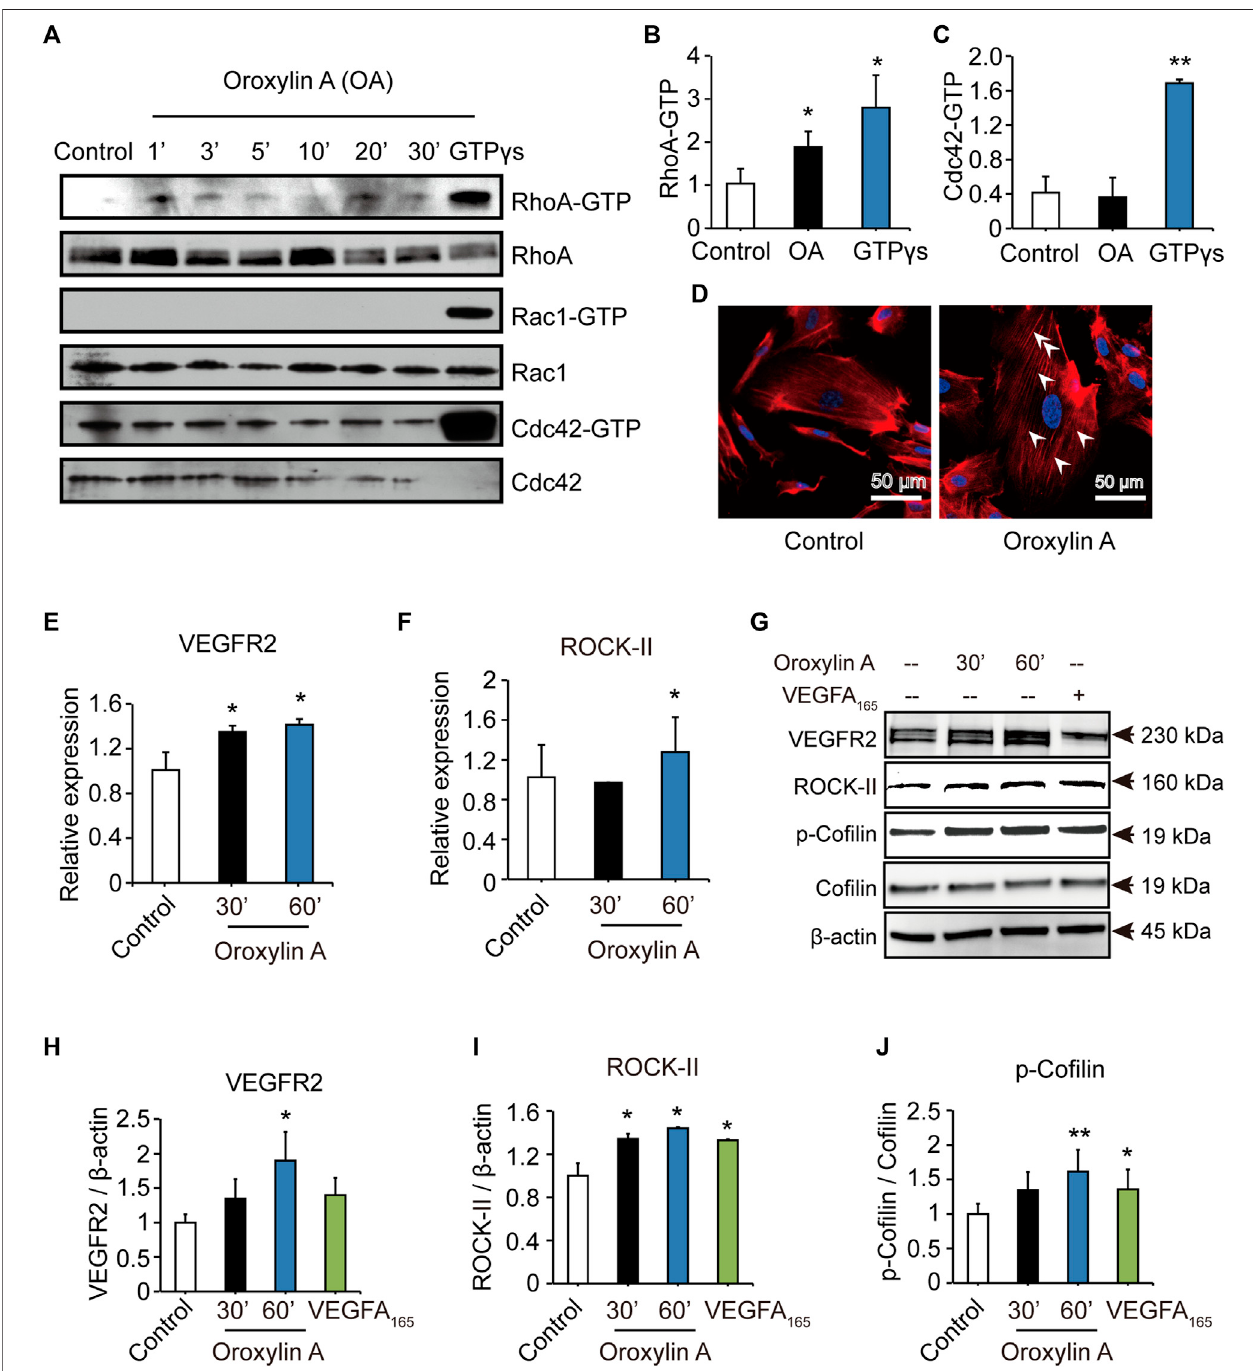
FIGURE 4 | OA induced stress fi ber formation and cell migration in HUVECs through RhoA/ROCK-II pathway. The amounts of active GTP-bound RhoA (RhoA- GTP,rhotekin-RBD),Rac1(Rac1-GTP,PAK-PBD),Cdc42(Cdc42-GTP,PAK-PBD)weredeterminedbyapull-downassay,innon-stimulated(control)orOA-stimulated (2.5 μ M) HUVECs for 1 min (1 ′ ), 3 ′ , 5 ′ , 10 ′ , 20 ′ or 30 ’ . Total RhoA, Rac1, Cdc42 in total cell extracts were also detected (A) . Quanti fi cation of active, GTP-bound state was presented as RhoA-GTP (20 ′ ) (B) and Cdc42-GTP (3 ′ ) (C) . HUVECs treated for 20 min with 2.5 μ M OA after serum were starved and subsequently stained with rhodamine-phalloidin and with DAPI for nuclei. RhoA induced actin stress fi bers were visible (D) . VEGFR2 (E) and ROCK-II (F) mRNA expression in HUVECs were stimulated with 2.5 μ M OA for 30, 60 min. HUVECs stimulated with DMSO, 2.5 μ M OA for 30, 60 min and VEGFA 165 for 60 min. Western blotting analysis of VEGFR2, ROCK-II or p -Co fi lin and total Co fi lin in HUVECs were performed. β -actin expression was presented as an internal control of protein loading. VEGFA 165 was acted as a positive control (G) . Quantitative data included VEGFR2 (H) , ROCK-II (I) and p -Co fi lin (J) . Data were represented asmean ± SD ( n (cid:2) 3). * p < 0.05; ** p < 0.01 vs. control.